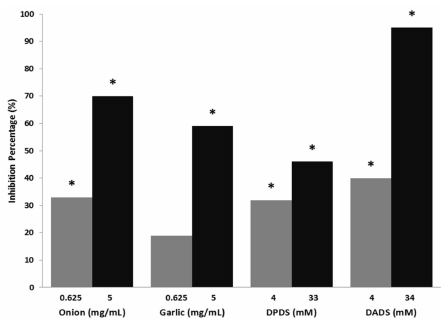
Figure 1. Mutagenicity inhibition percentages produced by onion, garlic, dipropyl disulphide (DPDS), and diallyl disulphide (DADS) against H 2 O 2 – DNA induced damage ( Drosophila melanogaster model). *: Statitiscal significance compared with the positive control using the Kastenbaum-Bowman binomial test with significance levels α = β =